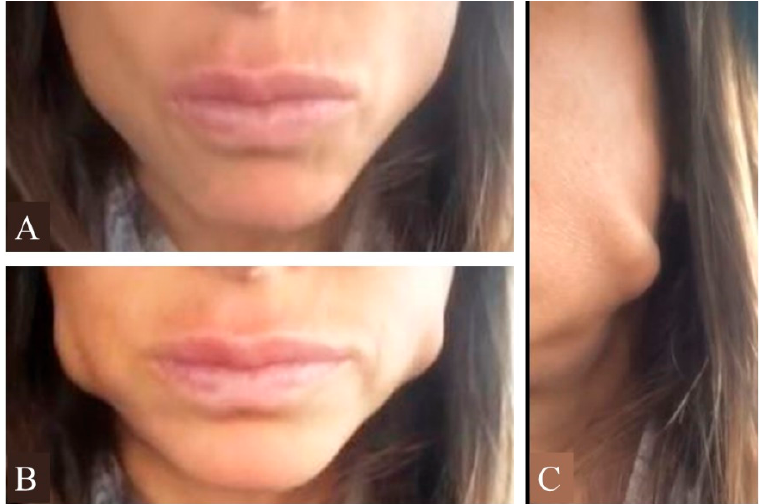
Figure 1. Morphologic aspect of bilateral masseter bulging on resting ( A ) and clenching ( B ) of the same patient showed in Video S1. Detail of masseteric belly affected by paradoxical bulging ( C ).